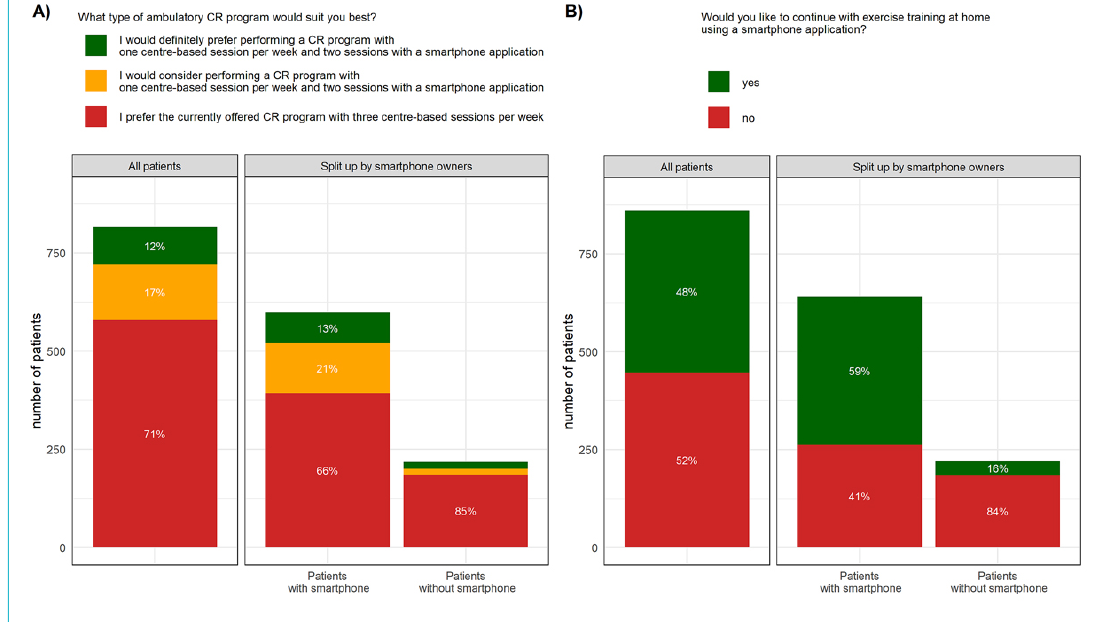
Figure 1: Interest in a smartphone application as part of the traditional cardiac rehabilitation (phase II, panel A) and for the long-term aftercare (phase III, panel B) overall and grouped by smartphone users and non-users.